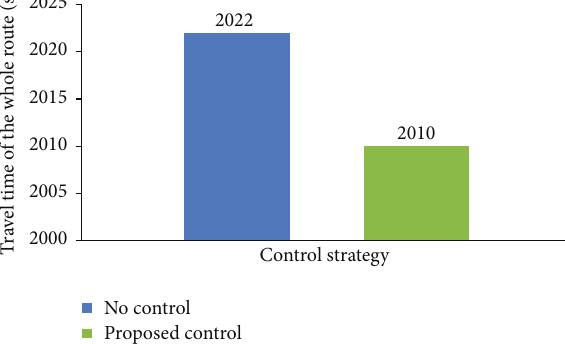
Figure 9: Comparison of travel time in different control